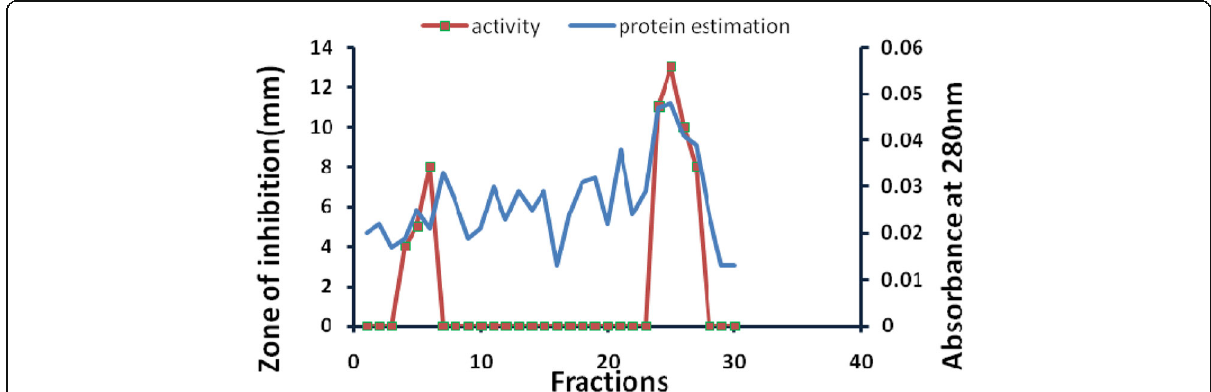
Fig. 4 Purification of bacteriocin by gel filtration chromatography. The blue line shows the protein content in terms of absorbance values at 280 nm, and the brown line shows the peak pertaining to bacteriocin activity